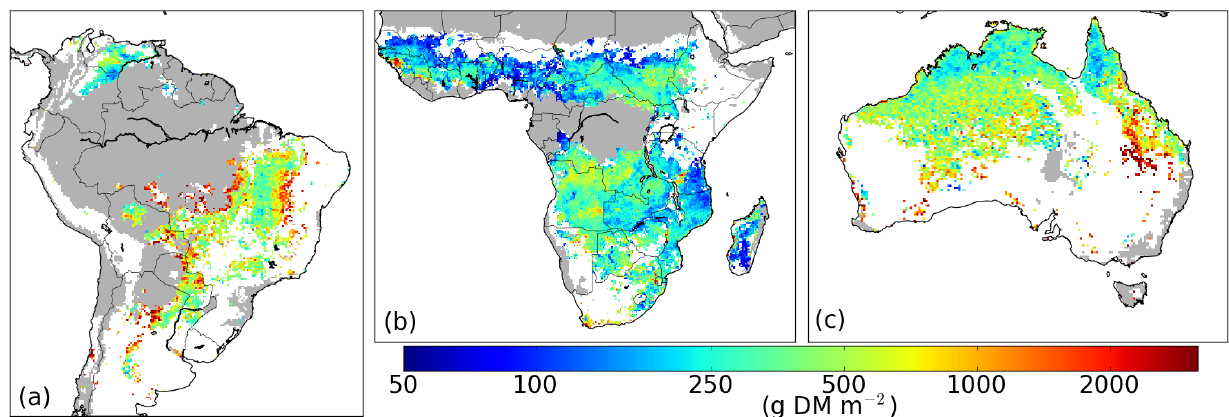
Figure 4. Distribution of fuel consumption based on MODIS-derived FRE per unit of area burned (2003–2014) and calibrated against field studies. (a) South America, (b) Sub-Saharan Africa and (c) Australia.